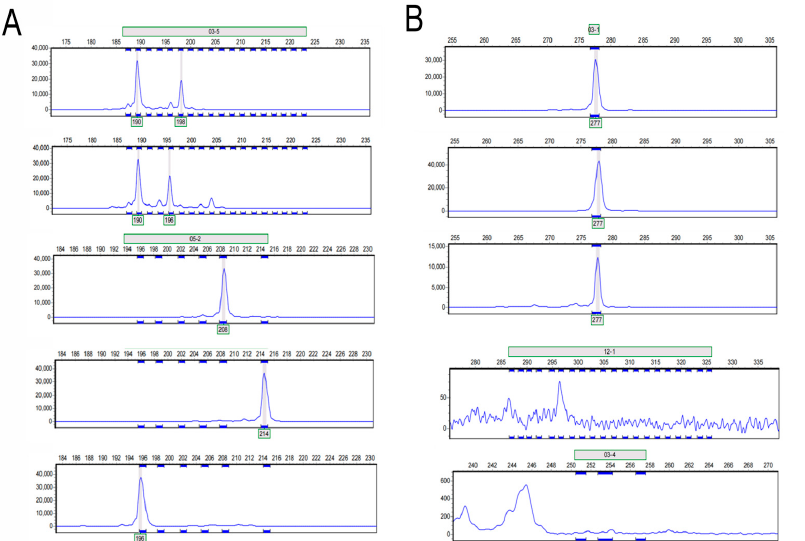
Figure 5. Examples of SSR primer amplification peaks and percentages of different types of polymor- phic SSRs. ( A ) Examples of SSR amplification peaks with good polymorphism. ( B ) Examples of SSR peak graphs for SSR amplification without polymorphism and failed SSR amplification. Table 4. Amplification characteristics of 33 CpTPSMSs.